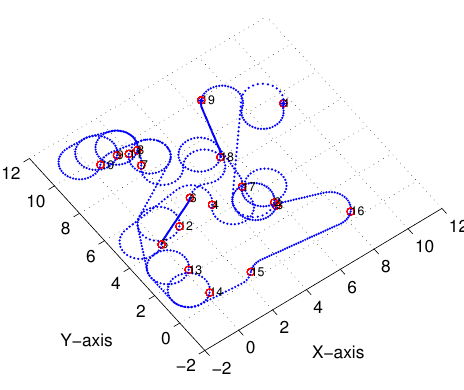
Figure 14. X – Y projection of linear-interpolation three-dimensional (3D) Dubins curves (case 1).